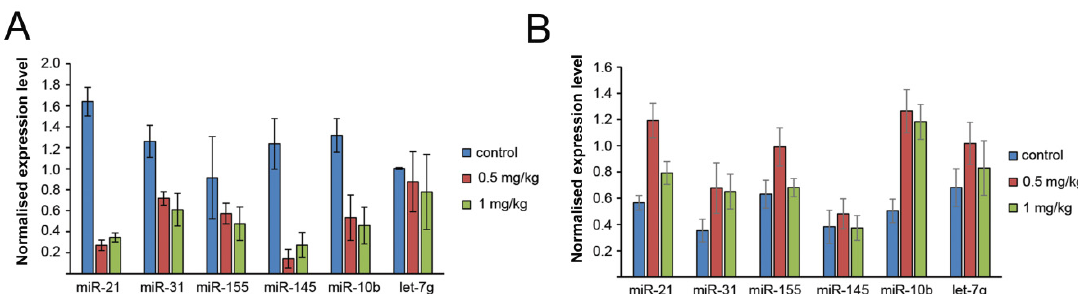
Figure 5. The e ff ect of binase on the level of miRNA in the tumour tissue and bloodstream of mice with RLS 40 . One hour after the last injection of binase, tumour and blood samples were taken, total RNA was isolated and the miRNAs were analysed using RT-qPCR. The miRNA profile in the blood of healthy animals was used for comparison with the miRNA profiles in mice with RLS 40 treated with saline bu ff er or with binase. ( A ) Analysis of the miRNA levels in blood serum and the expression level in tumour tissue ( B ) of mice with RLS 40 after the binase treatment at the doses of 0.5 and 1 mg / kg. The expression level of miRNAs in the tumour tissue was normalised to U6. The concentration of serum-derived miRNAs was normalised to the serum volume. Statistical analysis was performed using one-way ANOVA with the Tukey’s post hoc test; p < 0.05 was considered to be statistically significant.